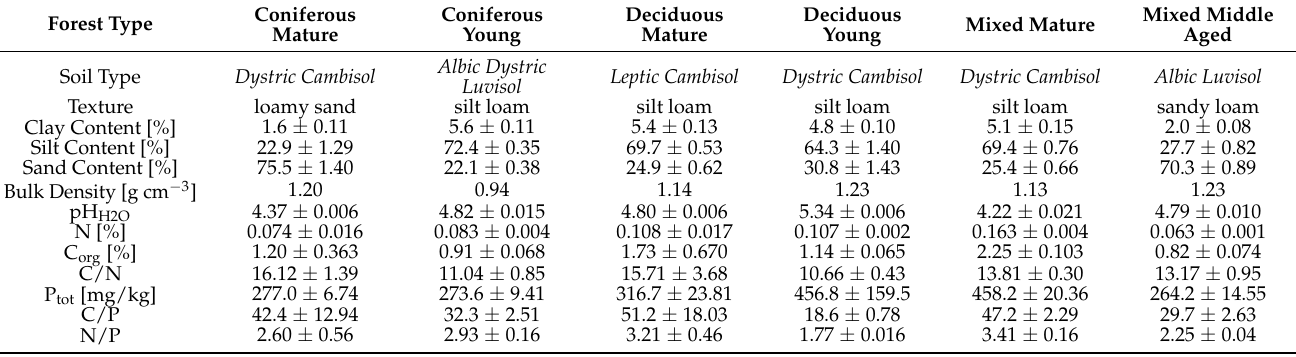
Figure 1. Meteorological parameters in the study region in 2018 and 2019, based on information from the weather station of the Institute of Agrophysics PAS located in Lublin. Basic soil properties (Table 2) were determined for samples collected from a depth of 0–15 cm ( n = 3) in July 2018 before the main experiment. Soil texture was measured by the laser diffractometer Mastersizer 2000 with the Hy- Table 2. Properties of the different forest soils (0–15 cm depth; n = 3 avg. ± dro G dispersion unit (Malvern Ltd., Malvern, UK). The following settings were used: two light sources of laser (633 nm) and diode (466 nm), stirrer speed 700 rpm, and pump speed 1750 rpm, soil refractive index 1.52 and soil absorption index 0.1 [51]. Soil pH was deter- mined potentiometrically at room temperature in a soil and water slurry, after the soil had settled, with a ratio of soil:water of 1:2.5 w/w. The total C and N contents were determined in soils ground in a mortar using a dry combustion method (an oven temperature of 1020 ° C; a Thermo Scientific Flash 2000 Organic Elemental Analyzer). Soil inorganic (SIC) and organic carbon (SOC) contents were determined with a TOC-VCPH analyzer (Shimadzu, Kyoto, Japan). Phosphorus (total P) concentration was determined by ICP-OES (Induc- tively Coupled Plasma Optical Emission Spectrometry) using a Thermo Scientific iCAP Series 6500 equipped with a charge injection device (CID) detector [52]. Soil temperature was measured during sampling using a TDR soil multimeter FOM/mts ( n = 8). Undis- turbed soil cores (100 cm 3 brass cylinders) were tested after equilibration on a Richard chamber (Soilmoisture Equipment Corp., USA) in order to determine soil bulk density as the mass of a dry sample divided by the volume of the sample.